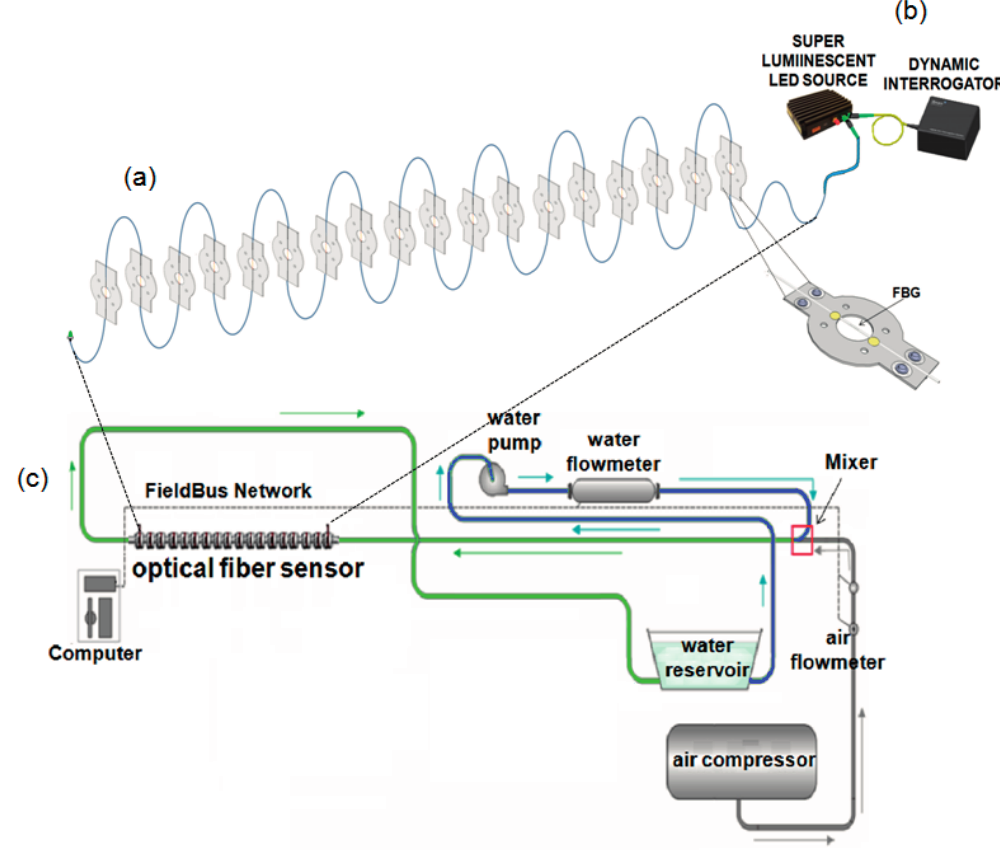
Figure 2. ( a ) Schematic drawing of the optical fiber strain sensors installed in a pipe; ( b ) Measuring setup; ( c ) Experimental rig for simulating different flow